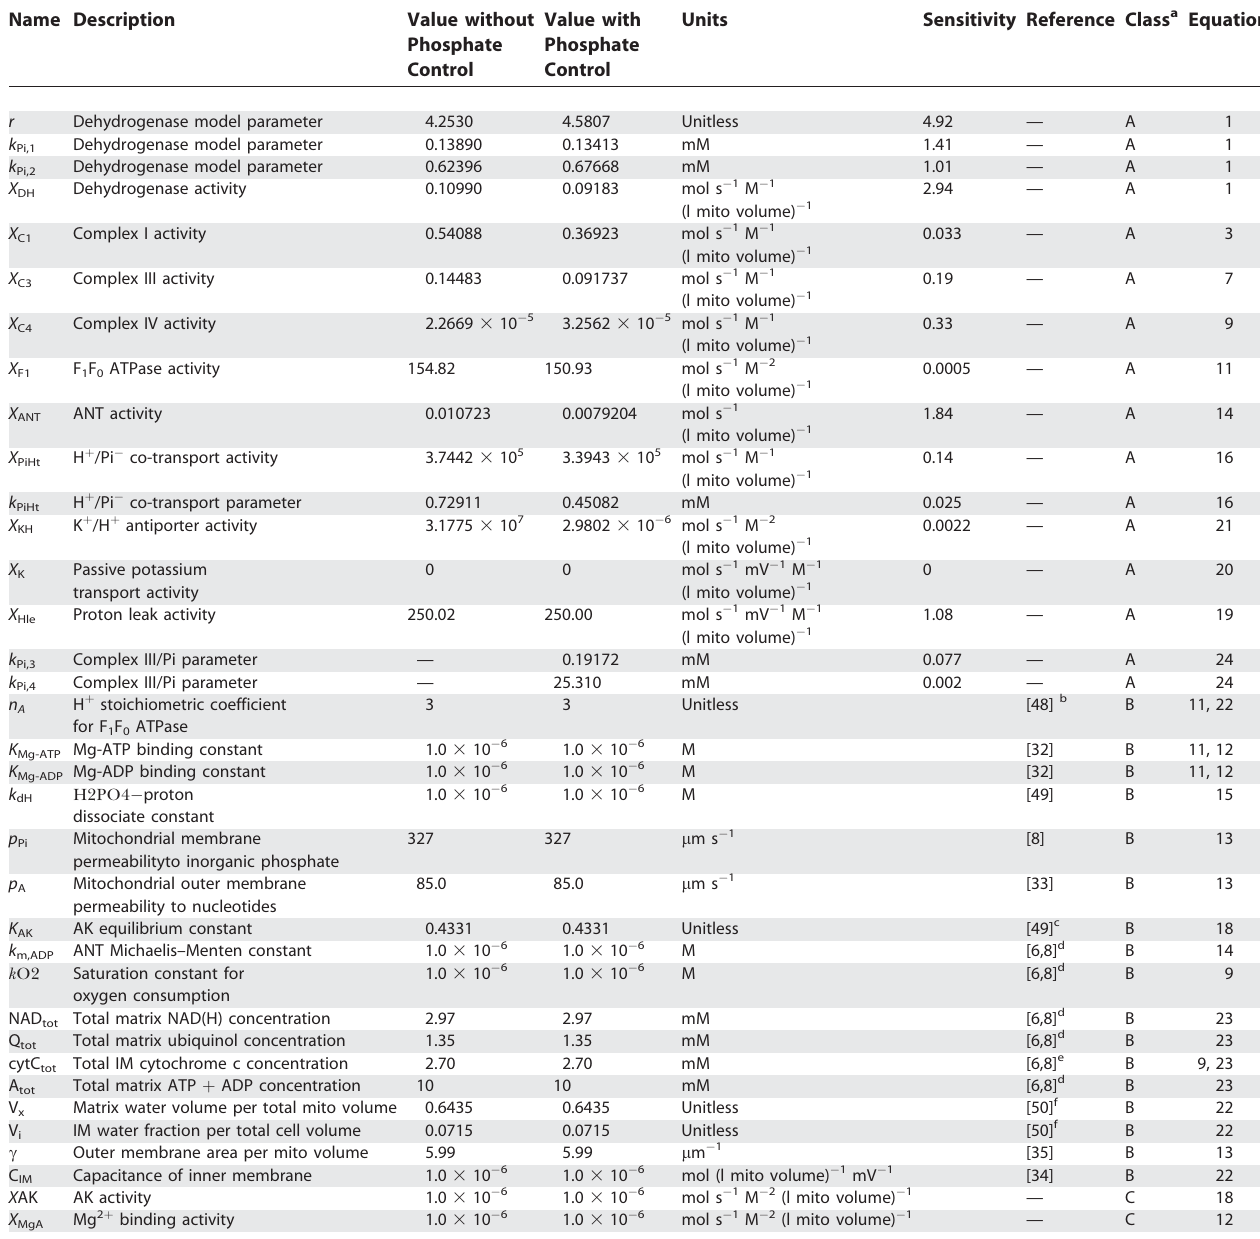
Table 1. Mitochondrial Model Parameter